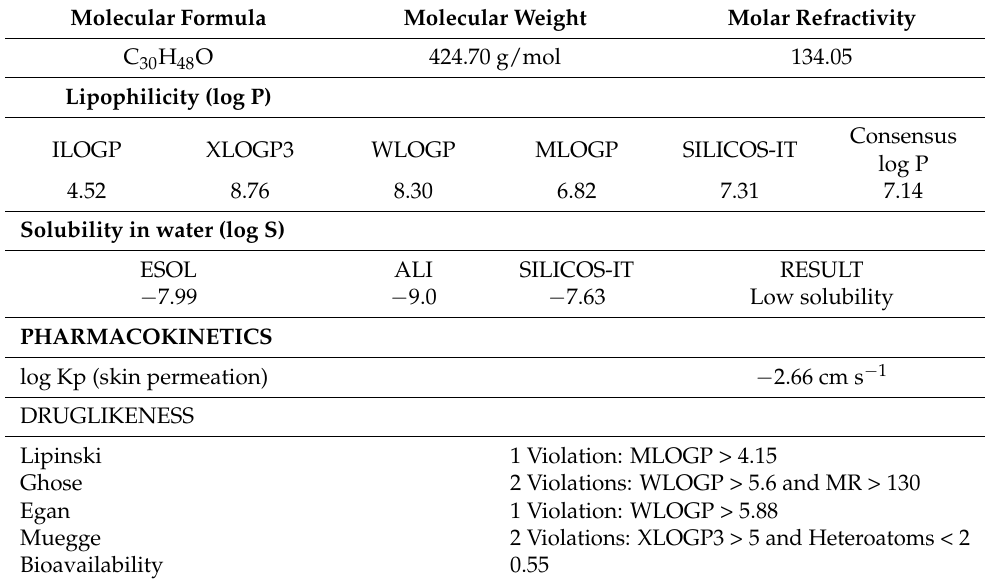
Table 1. Physicochemical properties, solubility, and lipophilicity profiles, and similarity to medicines (druglikeness) according to